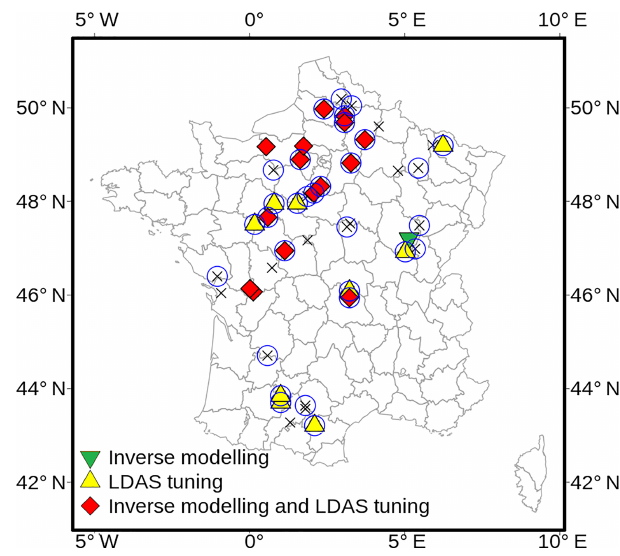
Figure 1. Straw cereal sites (35km × 35km) in France in 45 ad- ministrative units (“départements”). Triangle and diamond symbols show the départements presenting a significant temporal correlation ( R 2 > 0.41, F -test p value < 0.01) between Agreste GY values and LAIo max (blue circles), both inverse modelling and LDAS tuning (red diamonds), LDAS tuning only (yellow upward-facing triangle) and inverse modelling only (green downward-facing triangle). The “ × ” symbol indicates départements where no significant correlation between biomass simulations and GY could be